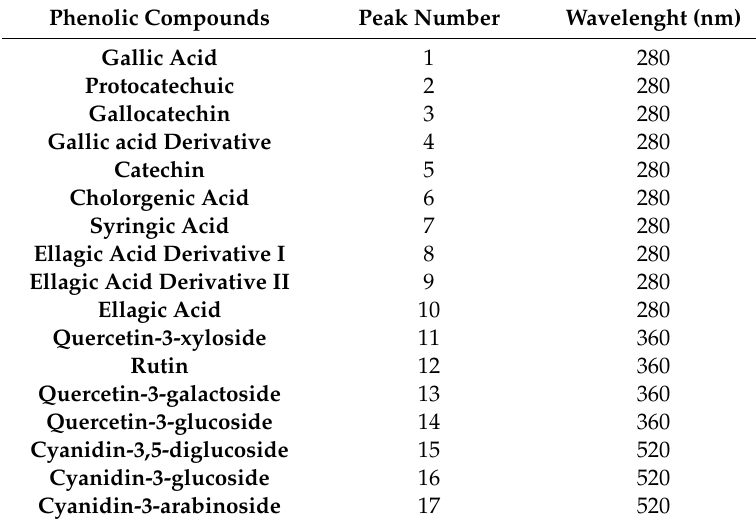
Table 2. Peak number and wavelength of phenolic